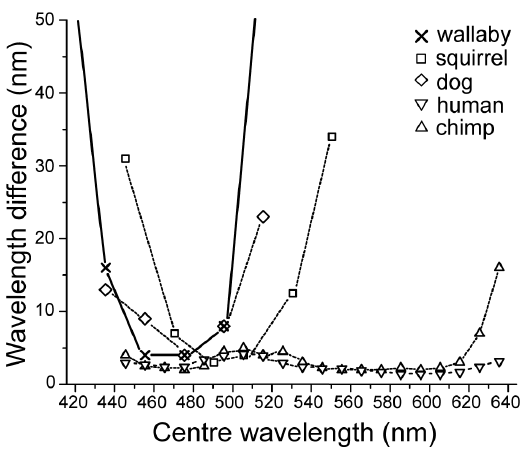
Figure 6. Minimum Delta Lambda functions for five mamma- lian species show differences between dichromats and trichro- mats. Trichromatic primates (triangles: [21]) exhibit good colour discrimination ability across a wide wavelength range. In contrast, the data from the wallaby (crosses) much more closely match the discrimination abilities of dichromatic mammals with good perfor- mance only over a narrow range of wavelengths (squares: tree squirrel [19]; diamonds: dog [20]).